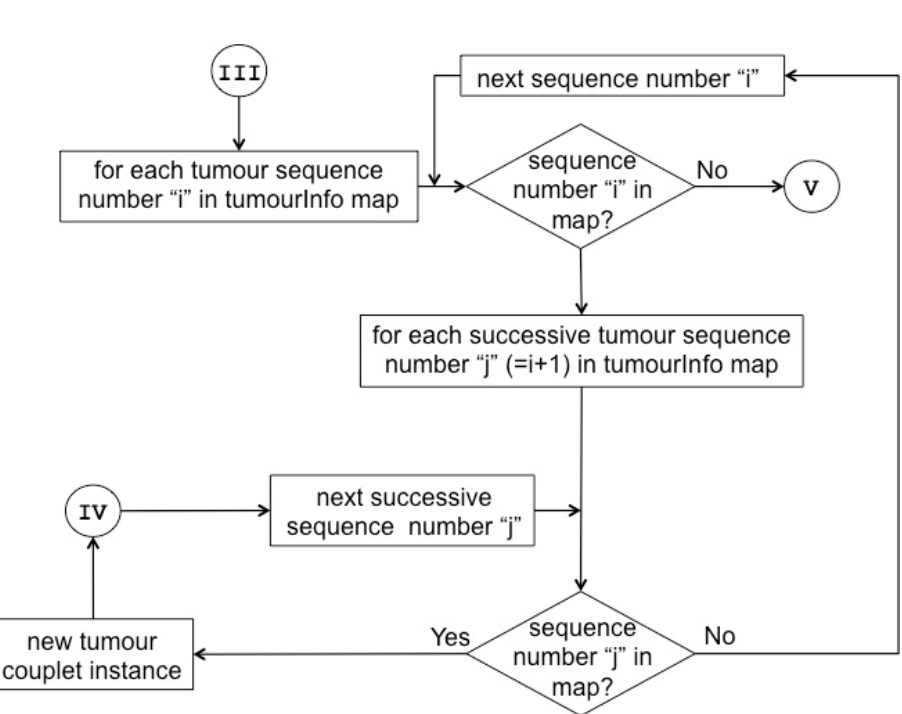
Figure A3. Flowchart for cycling through the tumour-couplet permutations in a case having multiple tumours. The connector labelled “IV” refers to the process described in Figure A4.